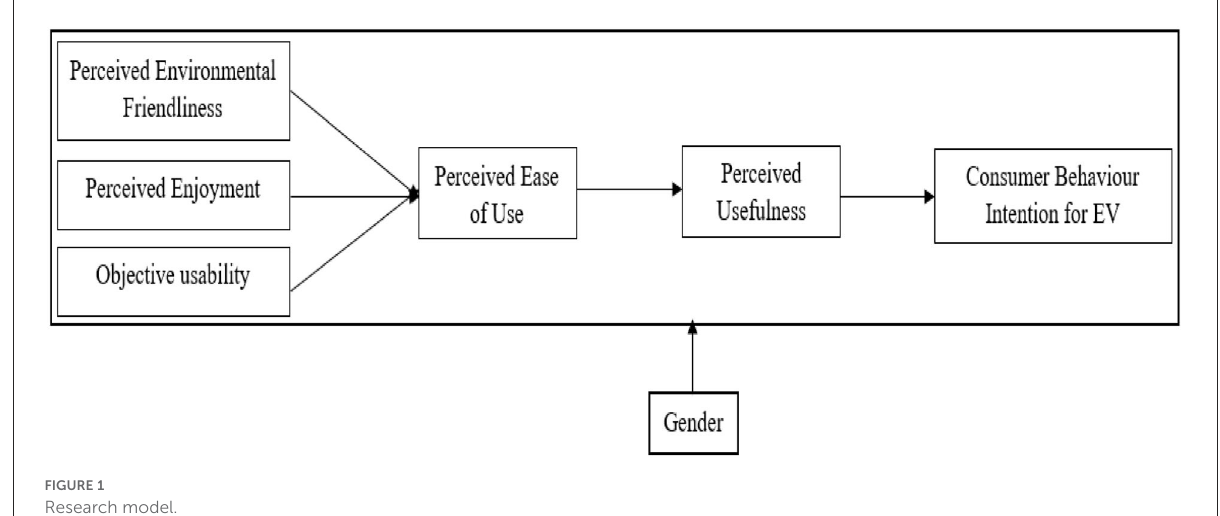
FIGURE1 Research